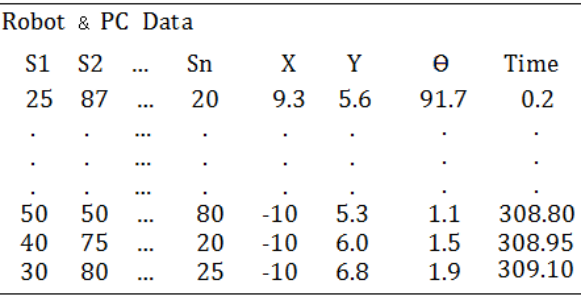
Figure 10. Robot and PC data